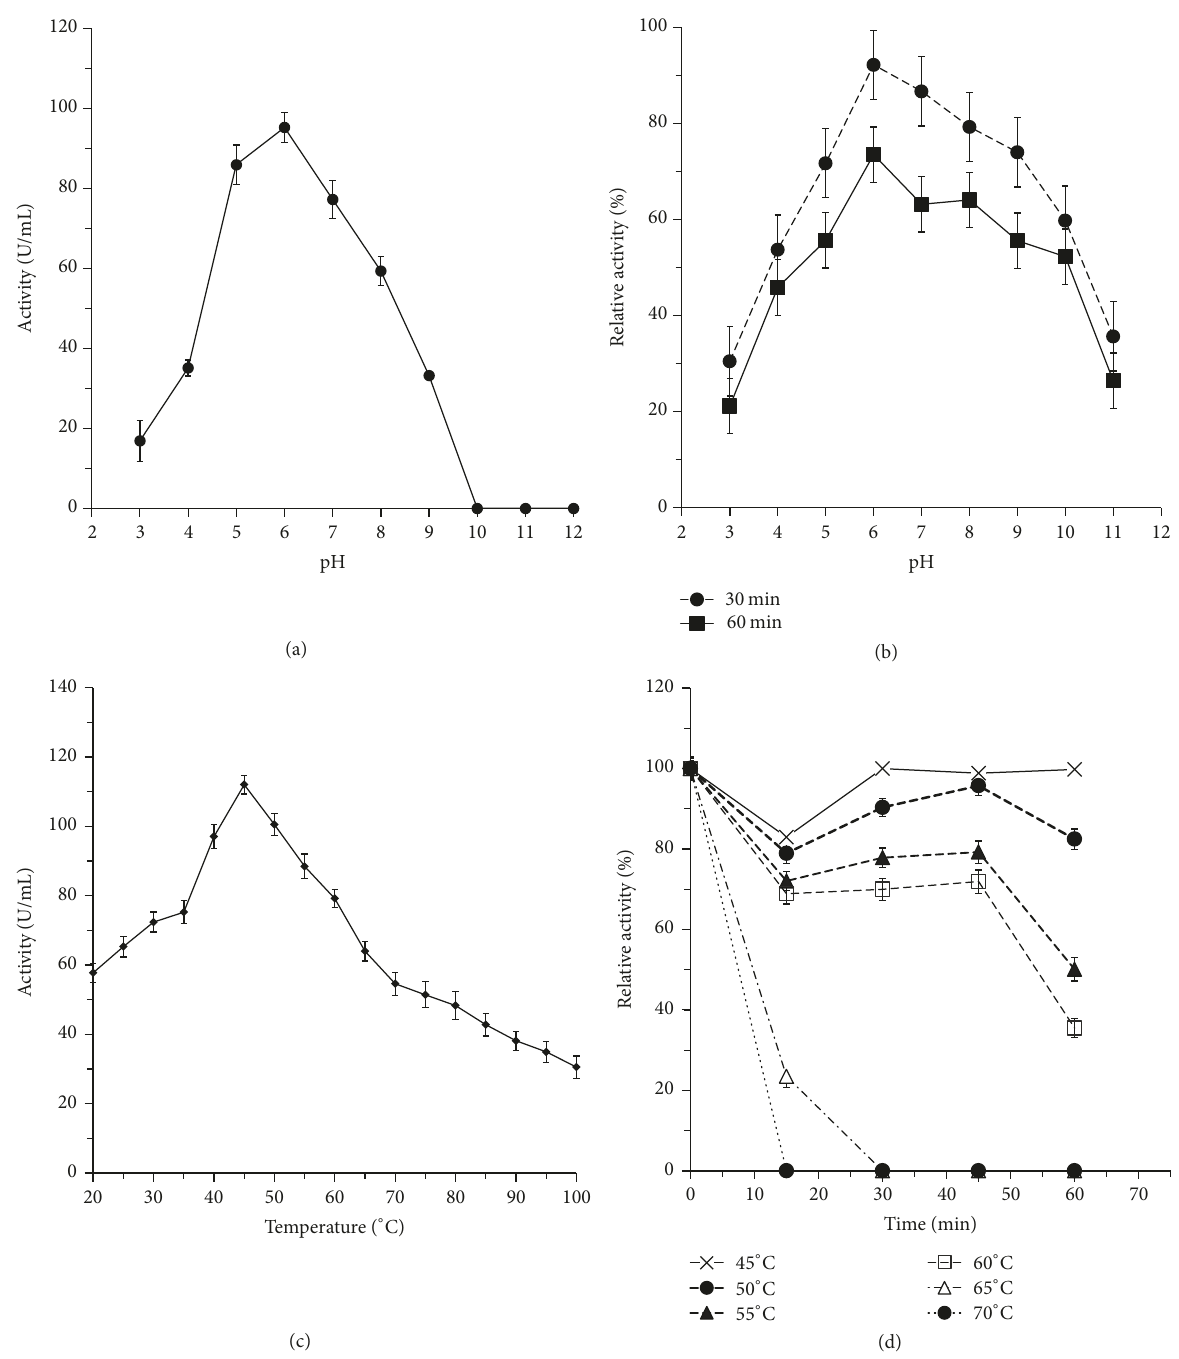
Figure 6: Effects of pH and temperature on the activity and the stability of the purified XynA MG 1 . (a) Effect of pH on activity at pH 3.0 to 11.0. The maximum activity was detected at pH 5.5 and was taken as 100%. (b) The pH stability of XynA MG 1 , incubated at pH 3.0 to pH 11.0 for 30 min and 60min, at 50 ∘ C. (c) Effect of different temperatures on the activity of XynA MG 1 . The maximum activity was detected at 45 ∘ C. (d) Thermal stability after incubation at 45 ∘ C to 70 ∘ C for various times. The data were presented as mean ± SD ( 𝑛 = 3